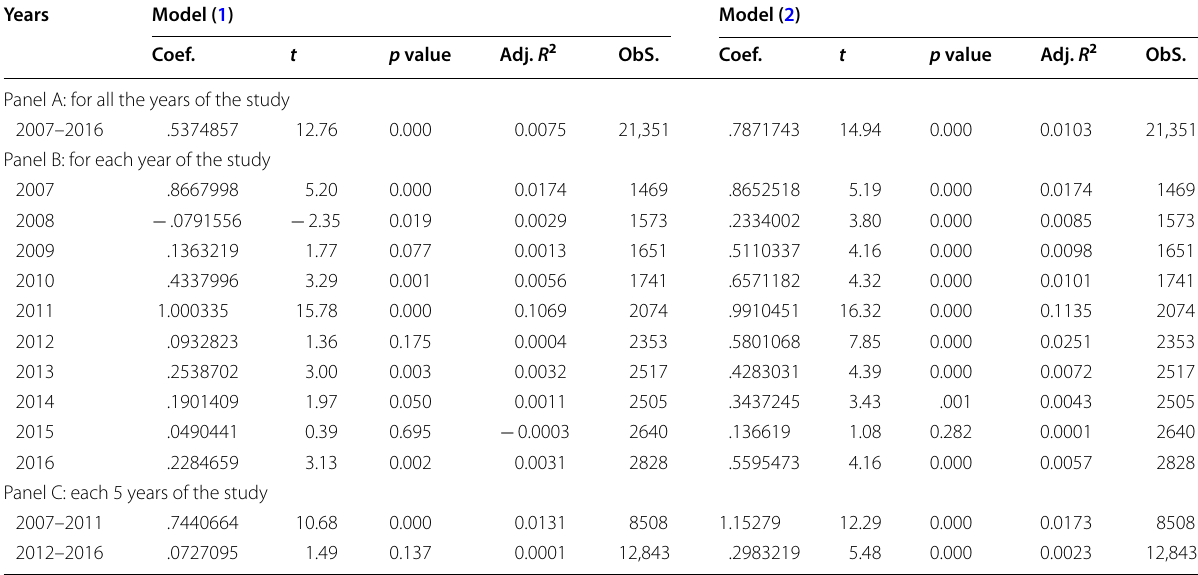
Table 3 Regression results using Models 1 a and 2